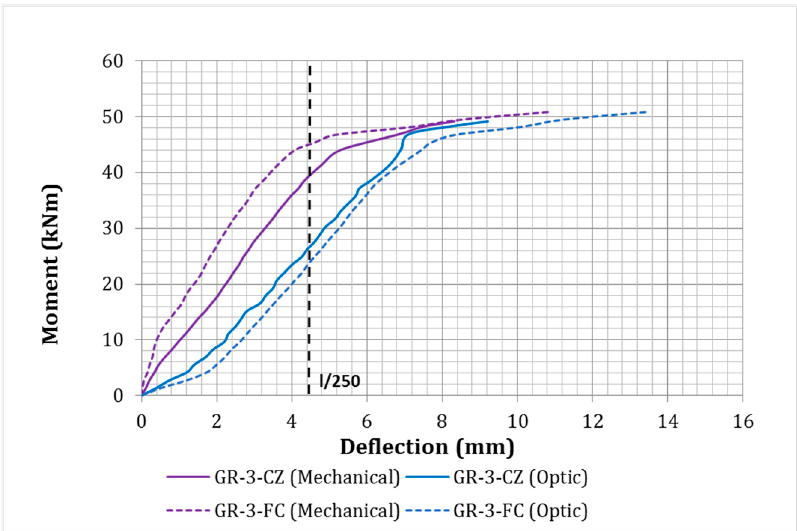
Figure 5. Moment-deflection curves according to mechanical and optical method.